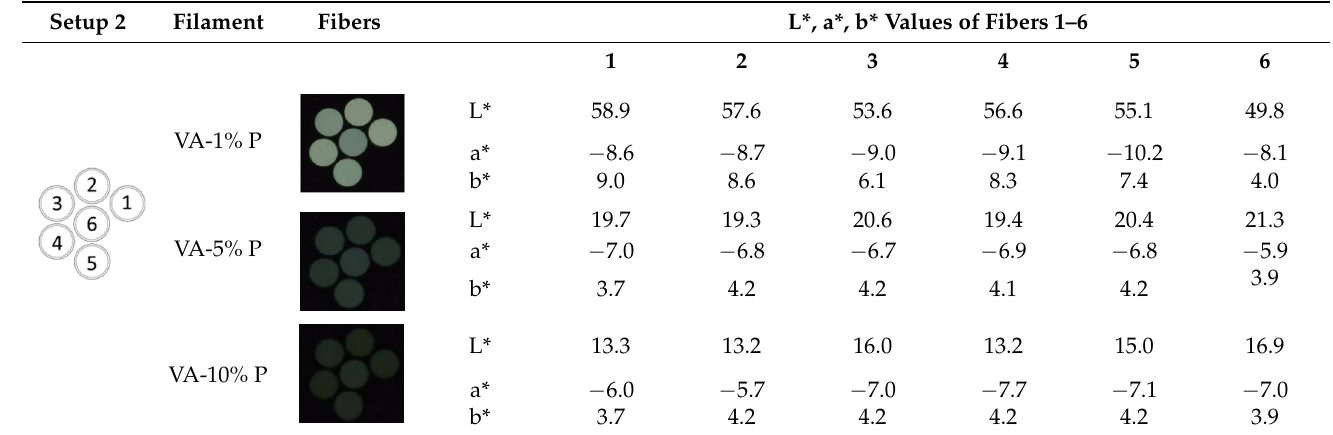
Table 3. L*a*b* values determined for fibers 1–6 using Setup 2 of VA-1% P, VA-5% P, and VA-10% P filaments at 2.50 V.